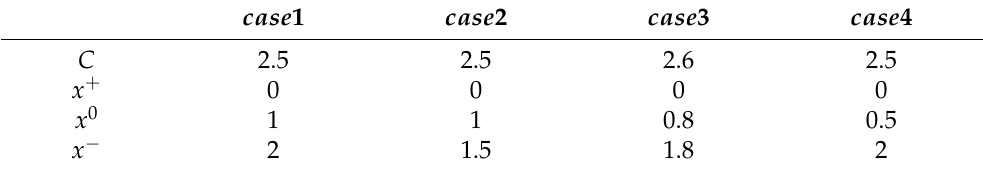
Table 3. Fitting parameters for density dependency ( C ) and isospin dependency ( x ) considered in this